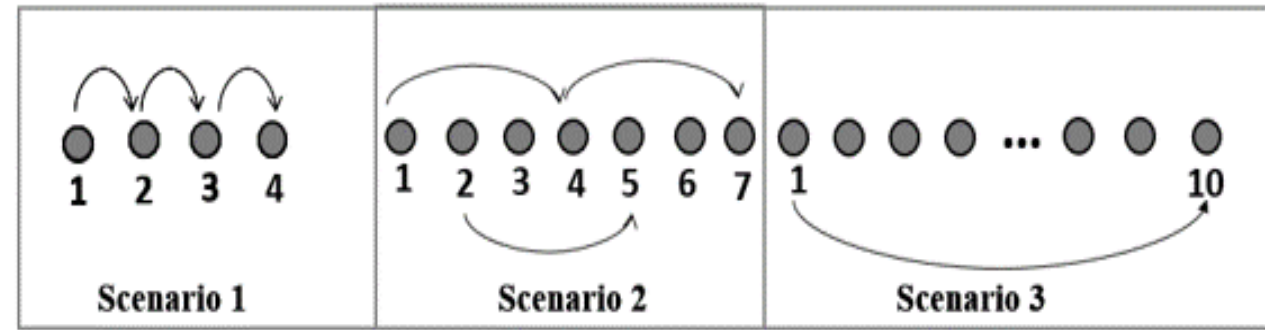
Figure 1. Multi-hop communication scenarios.